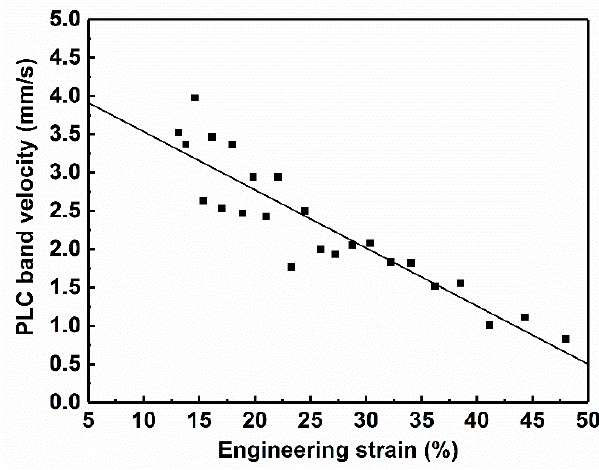
Figure 4. PLC band velocity during tensile test.